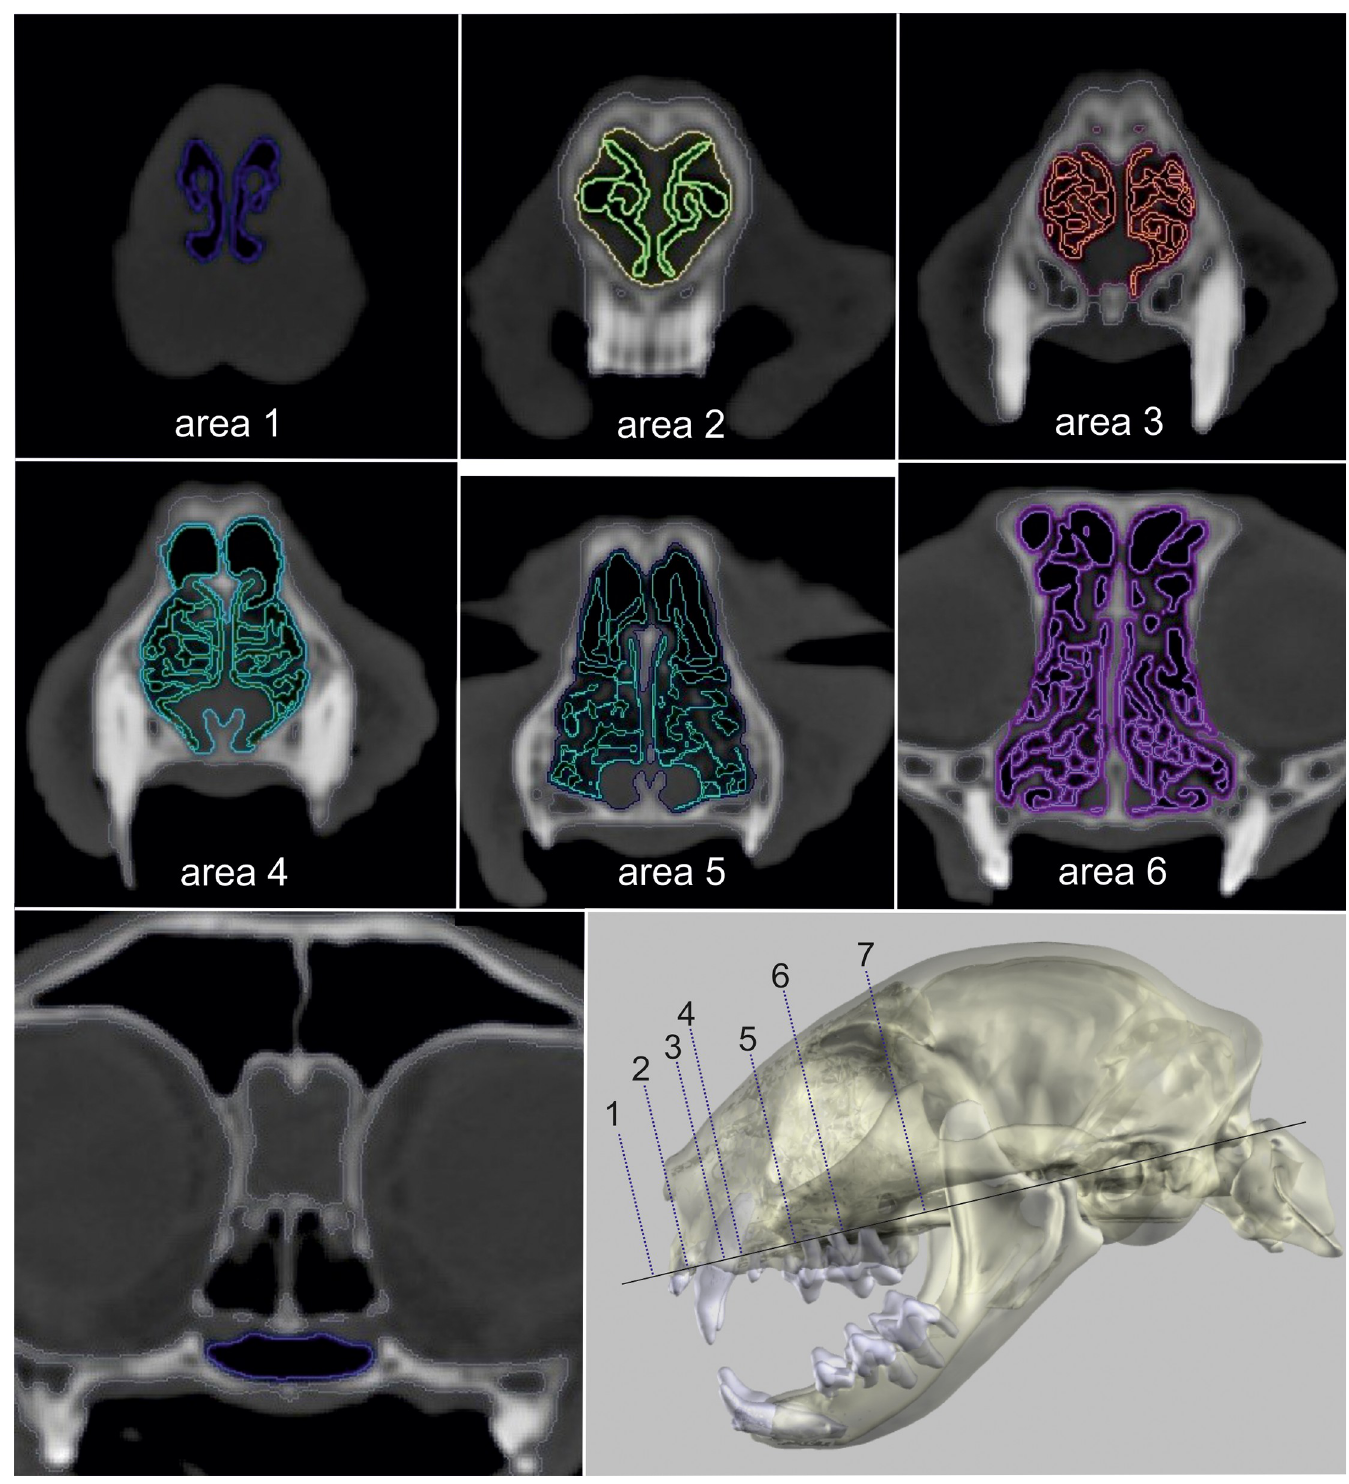
Fig 5. Measurement of nasal airway passage in a Domestic shorthair cat. Two-dimensional CT images in a transversal plane of the nasal cavity in a Domestic shorthair cat with segmentation of the airway passages and the surrounding tissues.